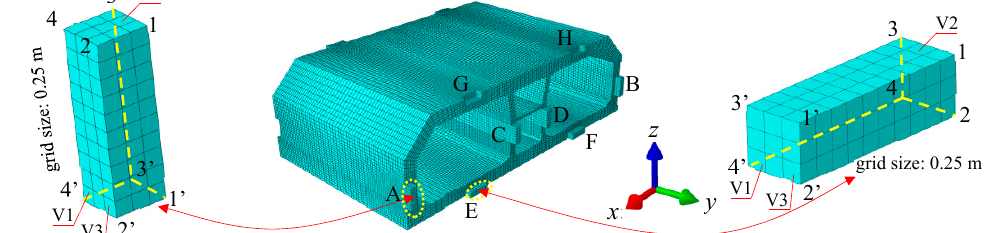
Figure 20. Distribution of shear keys at segment joint.